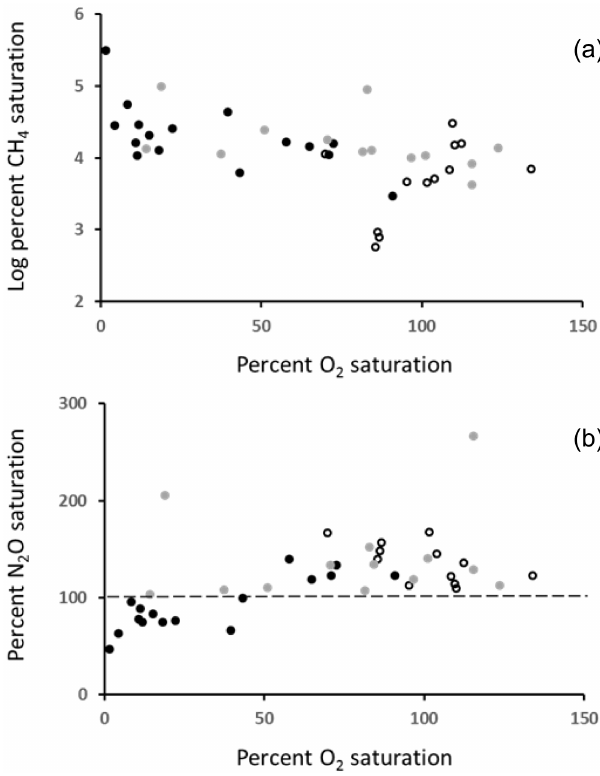
Figure 2. (a) Log percent dissolved methane saturation vs. percent dissolved O 2 saturation and (b) percent dissolved nitrous oxide sat- uration vs. percent dissolved O 2 saturation for rivers of the Republic of Congo during the wet season: open circles, savannah rivers; filled black circles, swamp forest rivers; filled grey circles, tropical forest rivers.